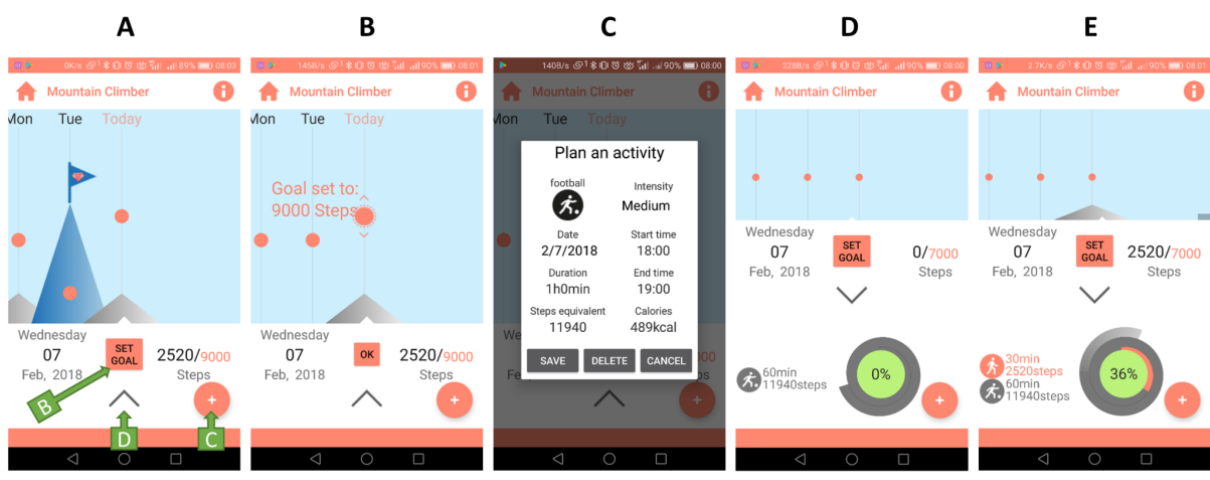
Figure 11. Implementation of the Mountain Climber self-regulatory tool. Screen A shows the main view, with blue mountain indicating an achieved goal. (Green tags on Screen A were not visible to users and are included here to indicate the destination screen after a tap action.) Screen B shows the step goal setting function. Screen C shows the action planning function. Action planning and logging are done by choosing an activity from a dropdown menu and setting the start and end time. The user can also adjust the intensity of the activity to either low, medium, or high, the default being medium. For ease of use, action planning is done in the same way as activity logging, with only the time being set in the future. The visual symbol of the planned activity appears in dim grey color, and the steps contribute to the daily total only after the user touches the button “I did it!”. Screens D and E show a detailed daily view, with planned activities in grey and completed activities in orange, indicating how many percentages of the daily goal is reached with the